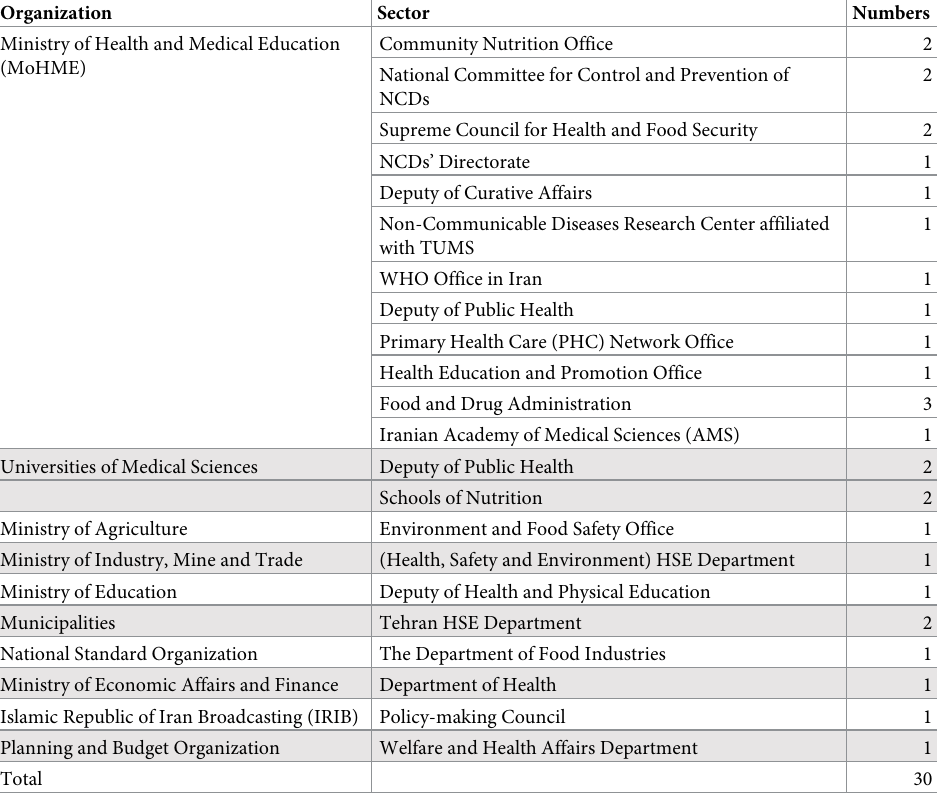
Table 1. Characteristics of the study